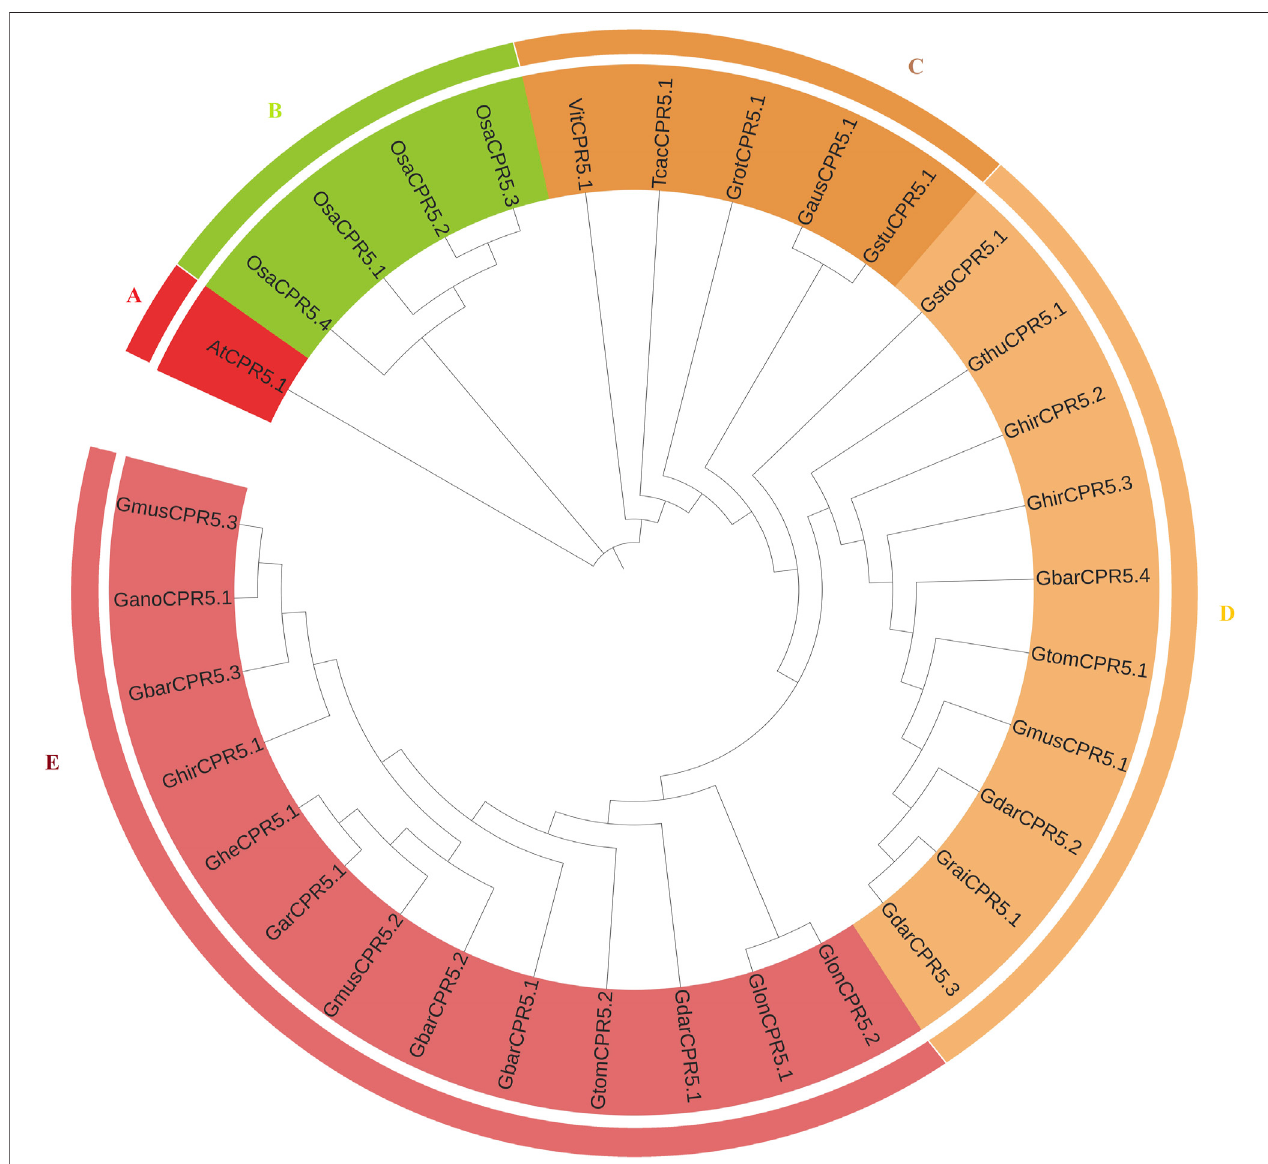
FIGURE 1 | Phylogenetic tree of CPR5 proteins from A. thaliana , O. sativa, Vitis vinifera, and Theobroma cacao . The CPR5 were divided into fi ve groups (A – E) on the clustering of the protein sequences. Cluster A contains one protein from A. thaliana , cluster B contains four proteins from O. sativa . Cluster C contains the proteins from G. herbaceum , Gossypium mustelium, Gossypium darwinii , Gossypium tomentosum, Gossypium hirsutum, Gossypium sturtianum, Gossypium austral, Gossypium rotundifolium. T. cacao, and Vitis vinifera , whereas, clades (D,E) contains 10 and 13 genes each belonging to Gossypium species.